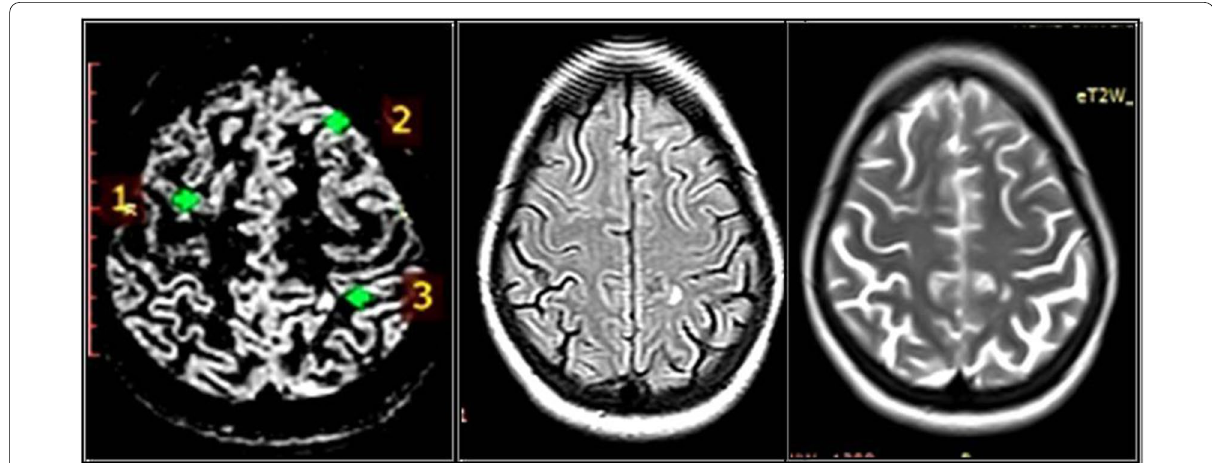
Fig. 2 Female 30-years-old with history of RRMS since 6 months presented by numbness and headache, EDSS sequences, respectively) show multiple MS plaques more obvious with more localization on DIR sequence. (1 3 WM lesion) =